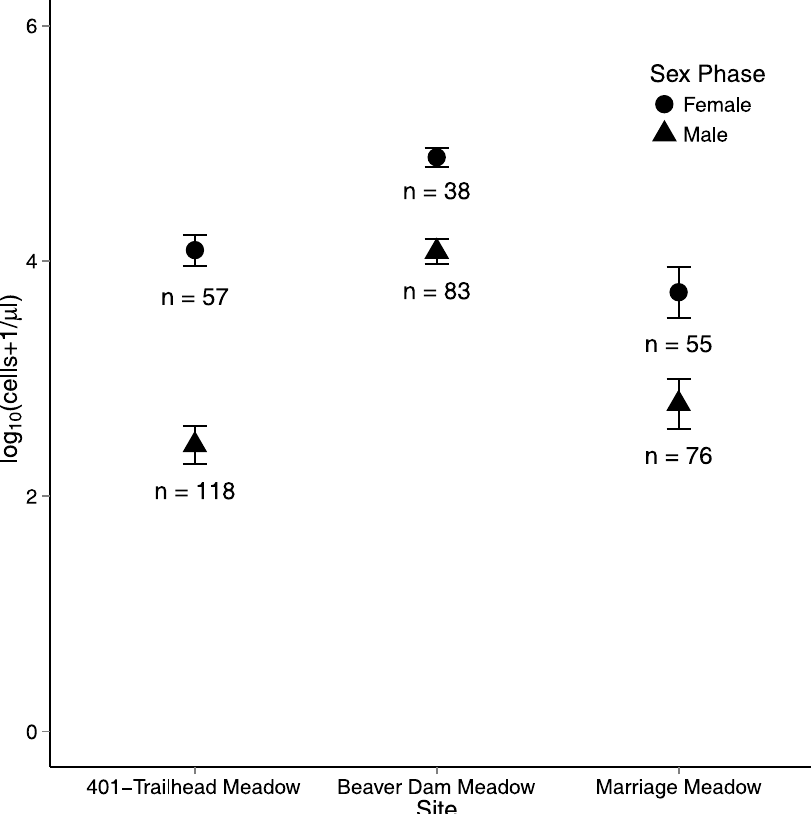
Figure 1. Yeast cell density (log 10 (x + 1) transformed) in the nectar of Delphiniumbarbeyi flowers of different sex phase (male and female) in three populations. Symbols represent means and vertical segments are 6 SE.